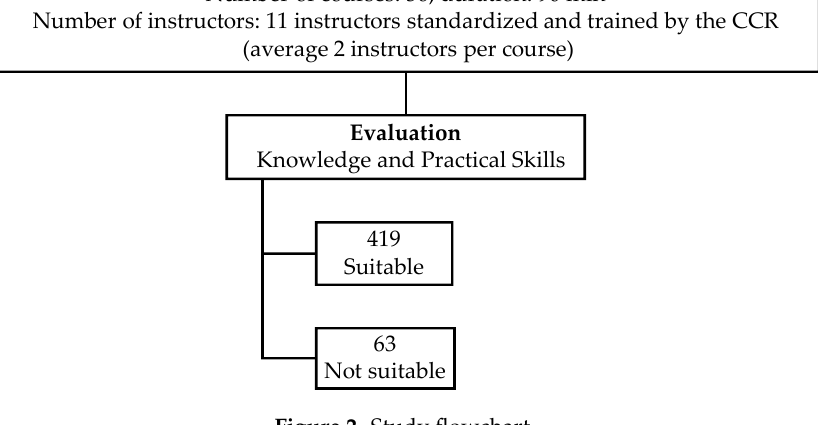
Figure 2. Study Figure 2. Study flowchart. Table 1. Sociodemographic characteristics of participants.